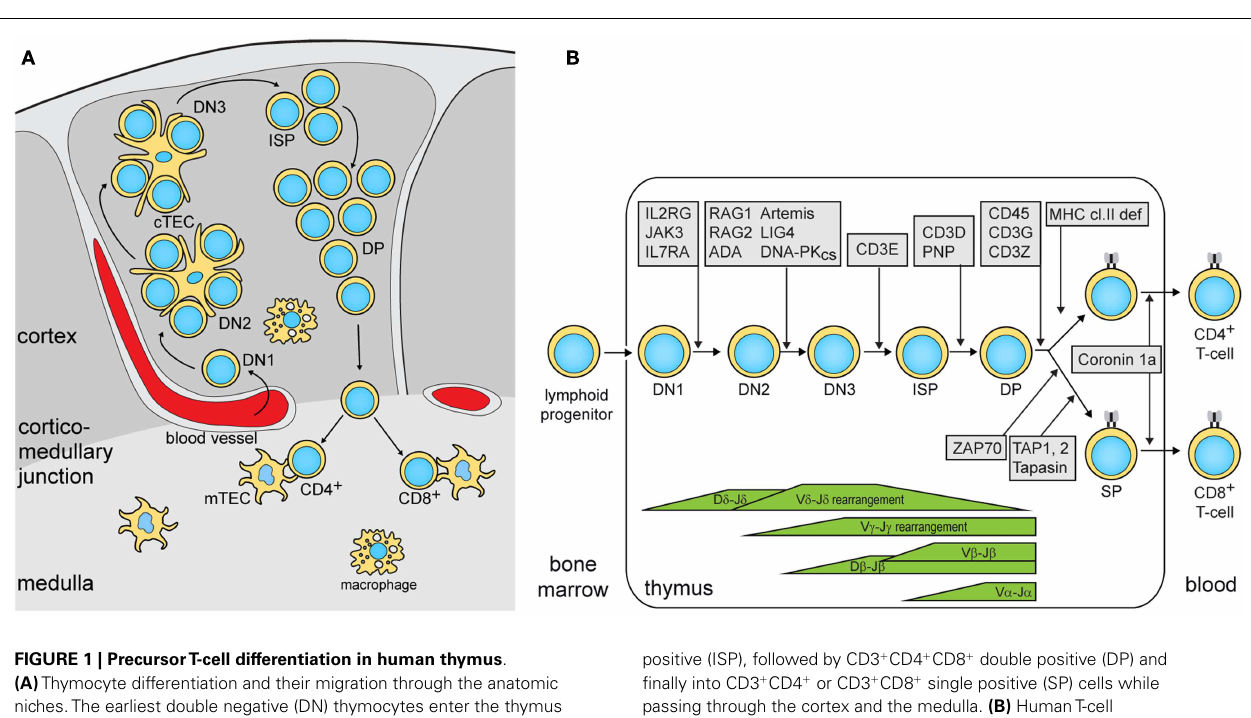
FIGURE 1 | PrecursorT-cell differentiation in human thymus . (A) Thymocyte differentiation and their migration through the anatomic niches.The earliest double negative (DN) thymocytes enter the thymus at the cortico-medullary junction and migrate to the sub-capsular zone. In humans, 3 DN subsets can be identified: DN1, CD34 + CD38 − CD1a − ; DN2, CD34 + CD38 + CD1a − ; DN3, CD34 + CD38 + CD1a + (14). Subsequently, these upregulate CD4 and become immature single